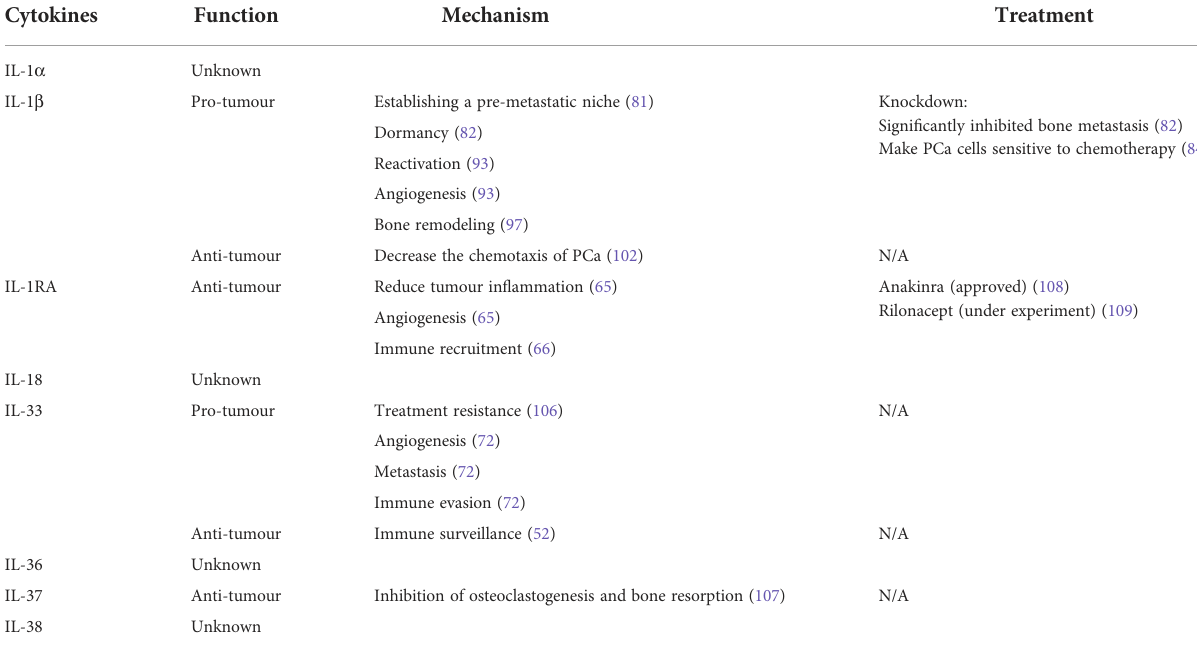
TABLE 1 Role of IL-1 family in bone metastasis and possible therapy which is currently